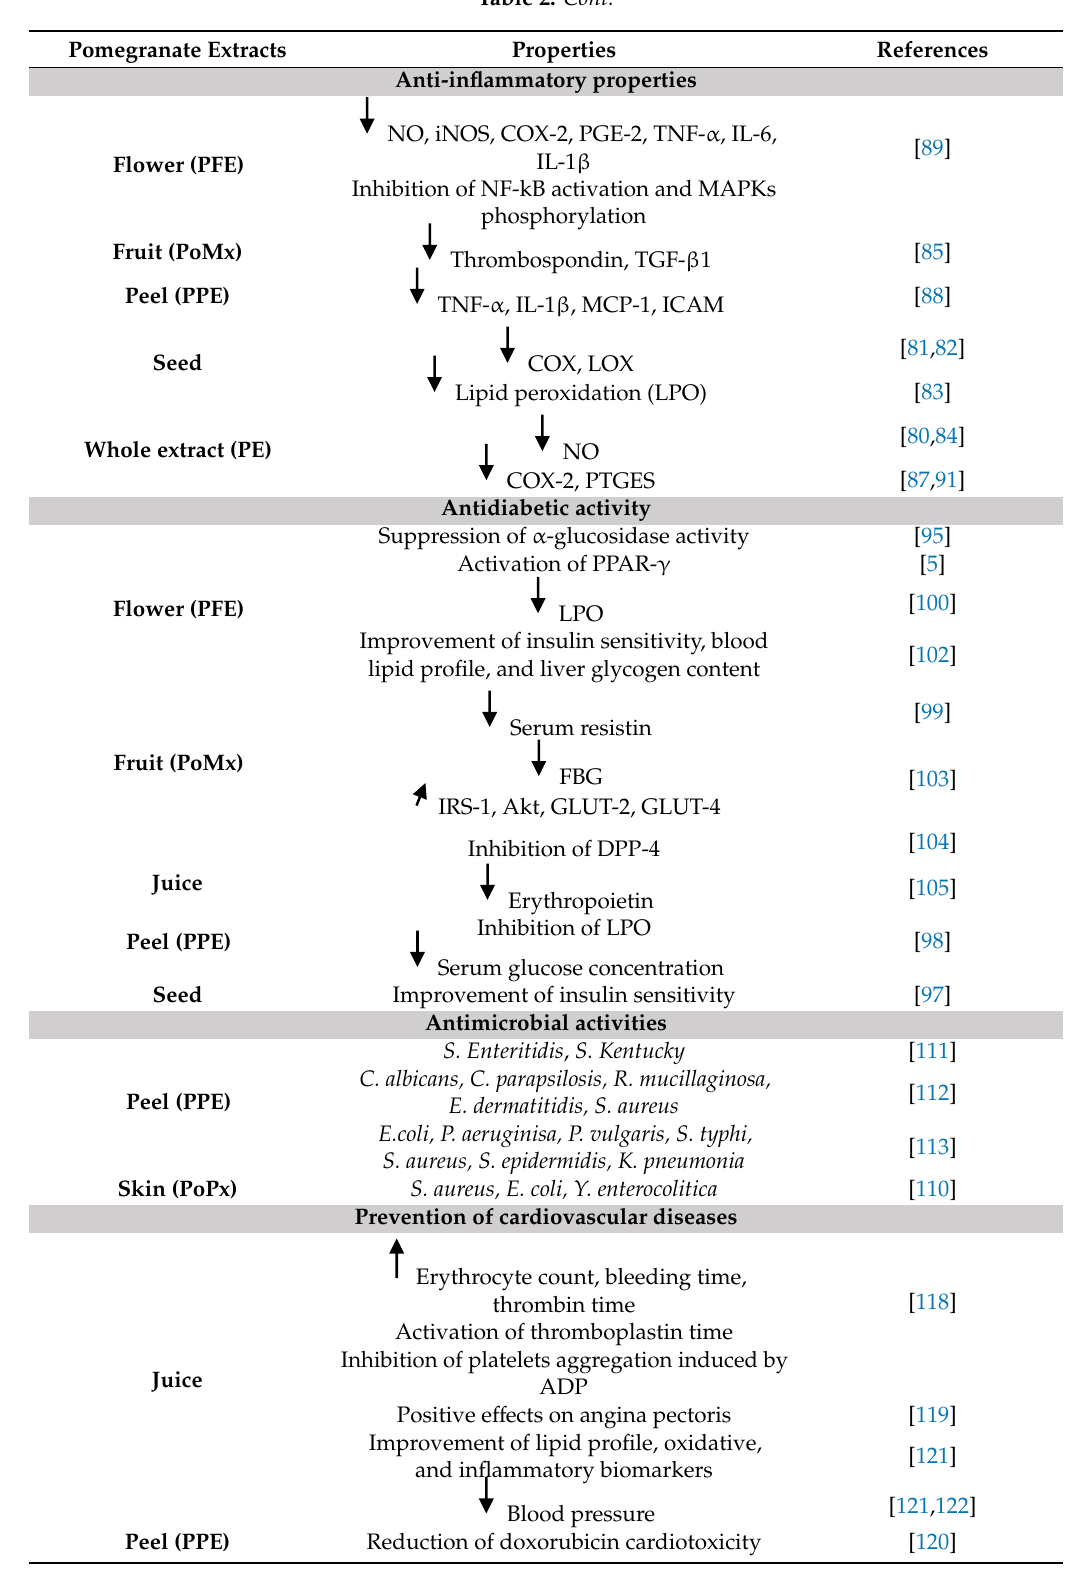
Table 2. Biological properties of different pomegranate extracts. Table 2. Cont.